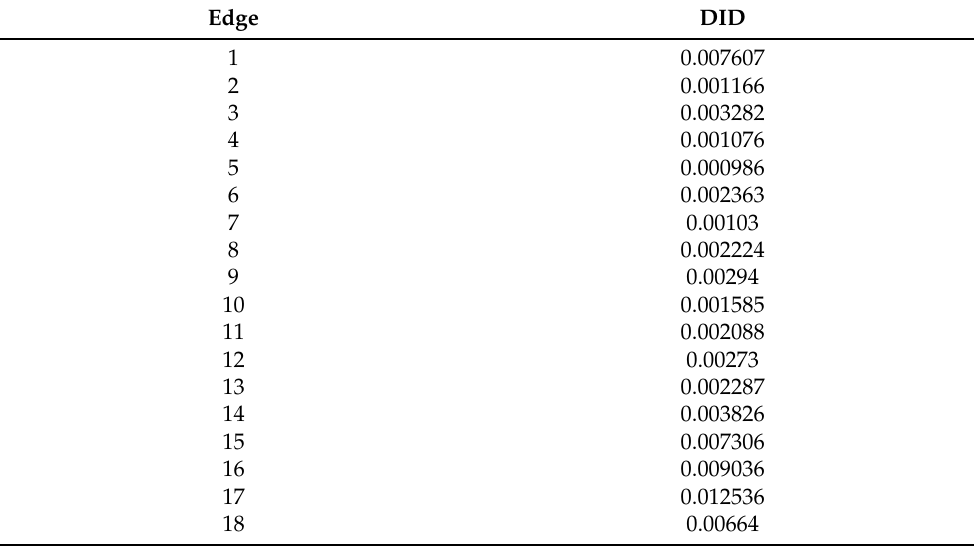
Table 3. DID of each edge in kite network.